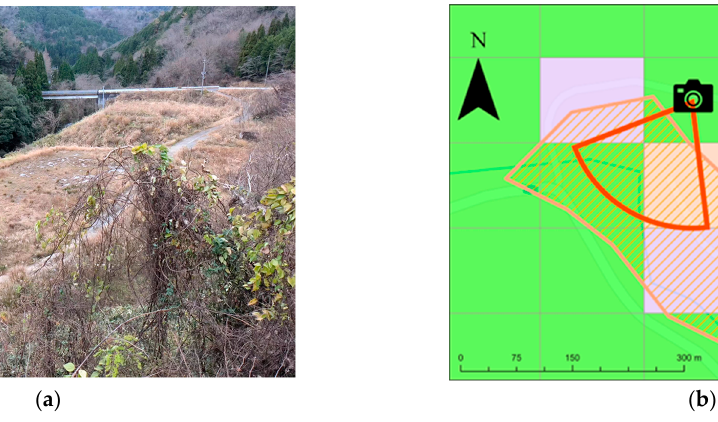
Figure 1. ( a ) Example of abandoned farmland; ( b ) depiction of the photo area, based on land use mesh data. Although the area was within an agricultural specialized zone, it was categorized as a “Miscellaneous site” (not “wasteland”) in the mesh data.